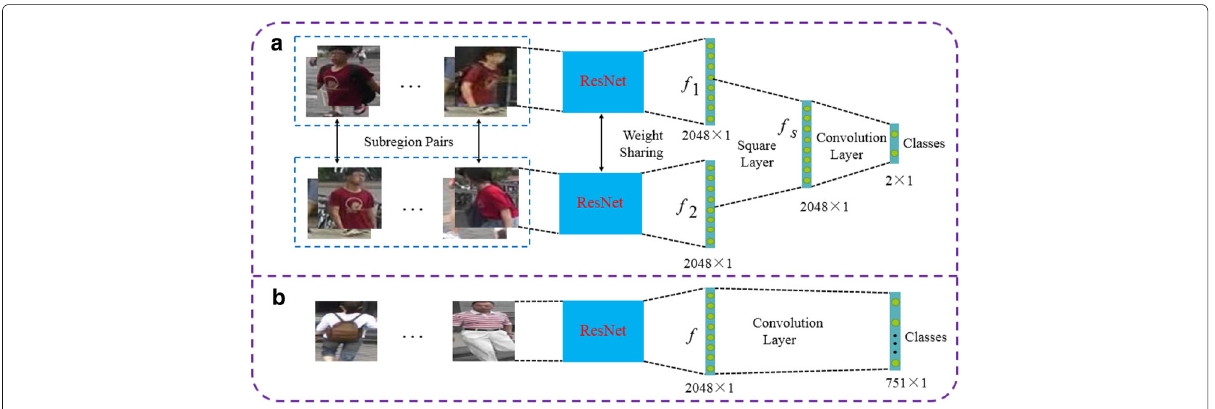
Fig. 2 The structures of a part-based and b body-based feature learning models subregions. Then, each subregion is randomly cropped to 224 × 224. Given subregion pairs as the input, we obtain two feature vectors f 1 and f 2 which are generated by aver- age pooling at the end of ResNet-50 models as shown in Fig. 2a. In order to connect the two networks, we employ a non-parametric layer called square layer [16] to compare the features f 1 , f 2 . The input of square layer is f 1 and f 2 , and the output is formulated as: